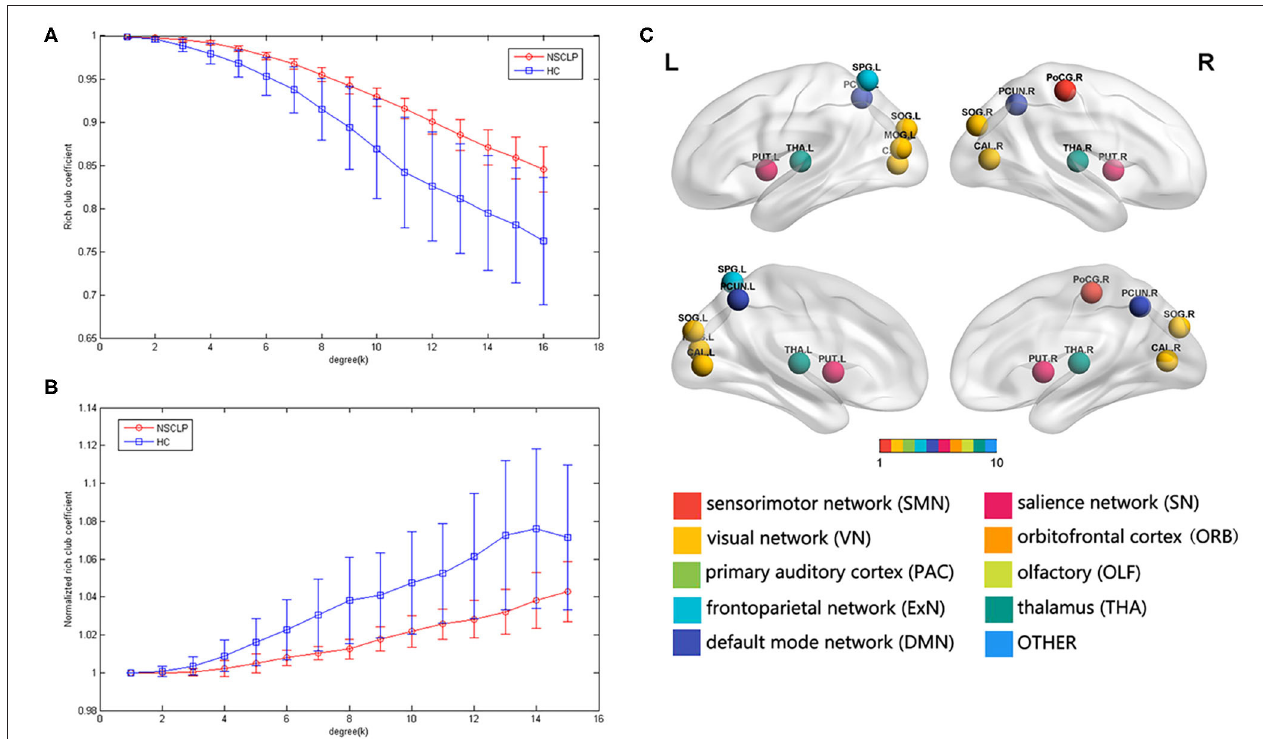
FIGURE 3 | (A,B) Group-averaged rich-club curve and standard error for patients (red) and controls (blue). (A) : rich-club coefficient ( Φ ), (C) : normalized rich-club coefficients ( Φ norm ). (C) : rich-club regions across the patients and controls. The color of the balls indicates the intrinsic connectivity